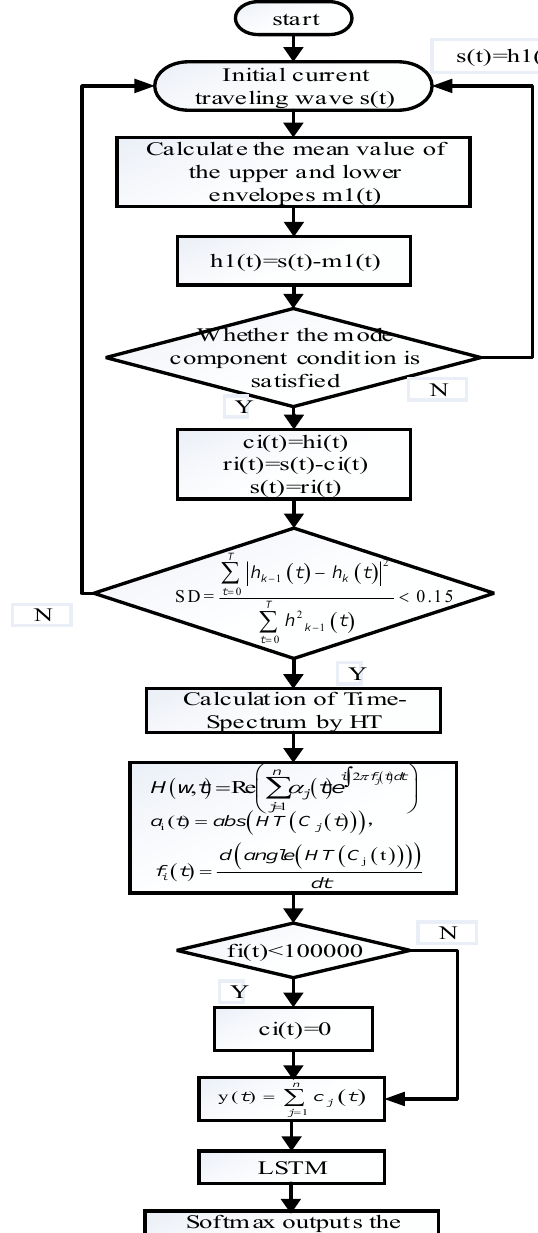
Figure 8. Flow Chart of Traction Network Transient Fault Classification.